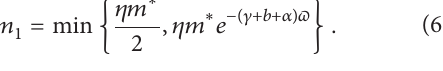
about 𝜂𝑚 ∗ for all large 𝑡 . However, Case (i) is obvious in